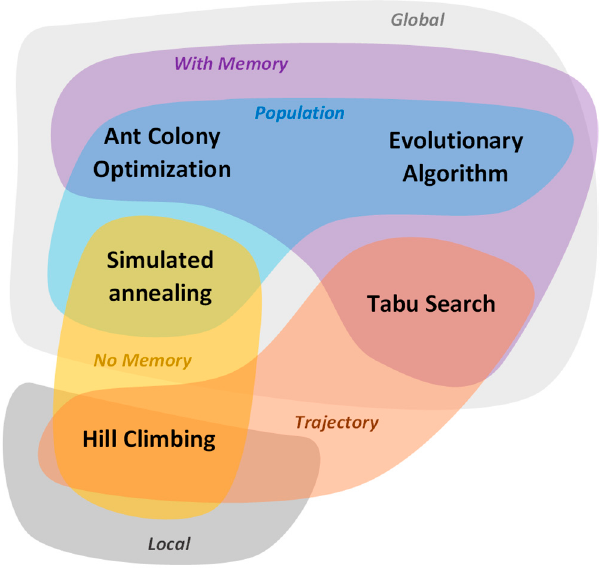
Figure 7. Venn diagram illustrating a metaheuristic algorithm classification.